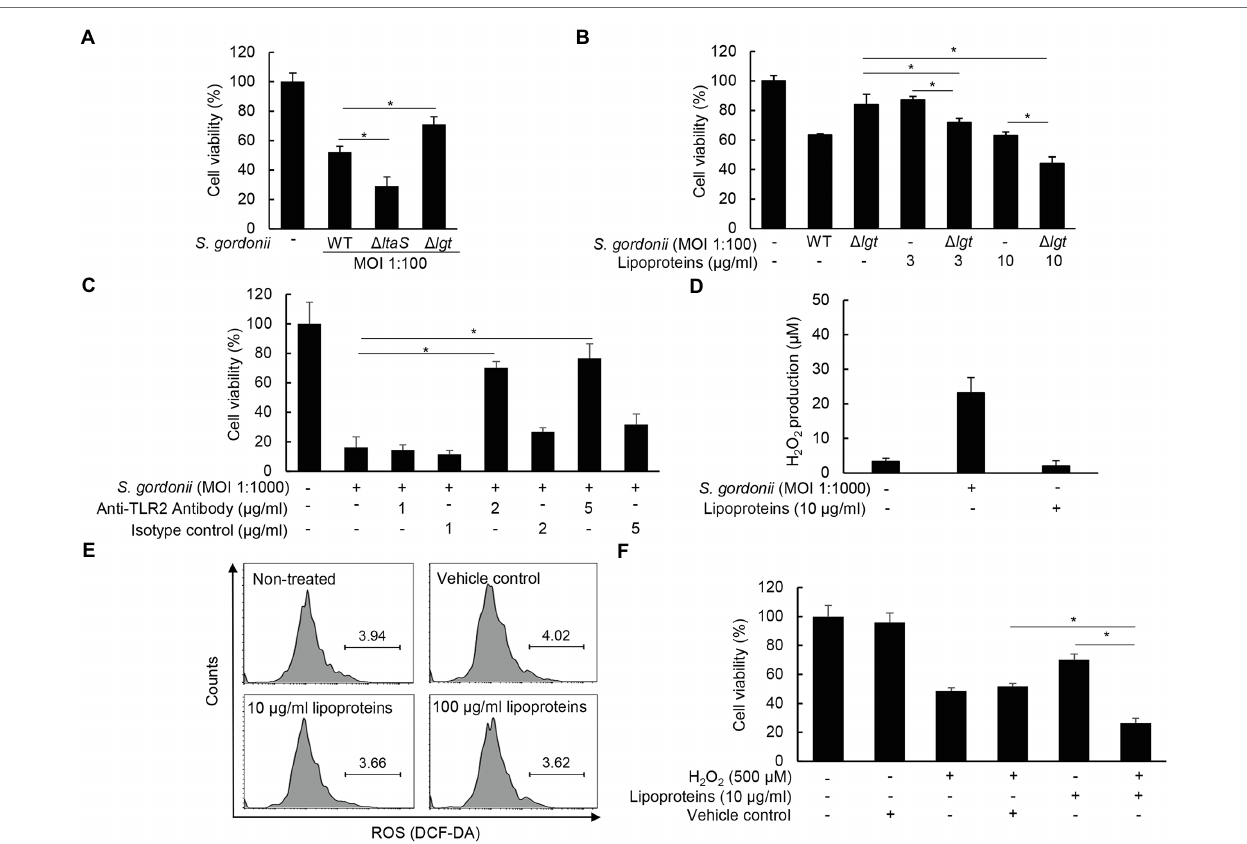
FIGURE 6 | S. gordonii lipoproteins contribute to the cytotoxicity of PDL cells in cooperation with H 2 O 2 . (A) PDL cells were treated with S. gordonii wild-type, its ΔltaS , and Δlgt at MOI 1:100 for 3 h. (B) PDL cells were treated with S. gordonii wild-type or its Δlgt at MOI 1:100 in the presence or absence of S. gordonii lipoproteins (3 or 10 μg/ml) for 3 h. (C) PDL cells were pre-treated with anti-TLR2 antibody (0, 1, 2, or 5 μg/ml) for 1 h, followed by treatment with S. gordonii at MOI 1:1000 for 3 h. Trypan blue assay was used to determine the number of viable cells. (D) PDL cells were treated with S. gordonii at MOI 1:1000 or S. gordonii lipoproteins (10 μg/ml) for 1 h. The level of H 2 O 2 in the supernatant was determined using a hydrogen peroxide assay kit. (E) PDL cells were treated with 10 µM of DCF-DA for 30 min at 37°C. The DCF-DA-treated cells were washed with PBS and then treated with S. gordonii lipoproteins (10 or 100 μg/ml) for 3 h in a CO 2 incubator. Fluorescent intensity was analyzed by flow cytometry. (F) PDL cells were treated with S. gordonii lipoproteins (10 μ g/ml) in the presence or absence of H 2 O 2 for 3 h. Trypan blue assay was used to determine the number of viable cells. One of three similar results is shown. * p <